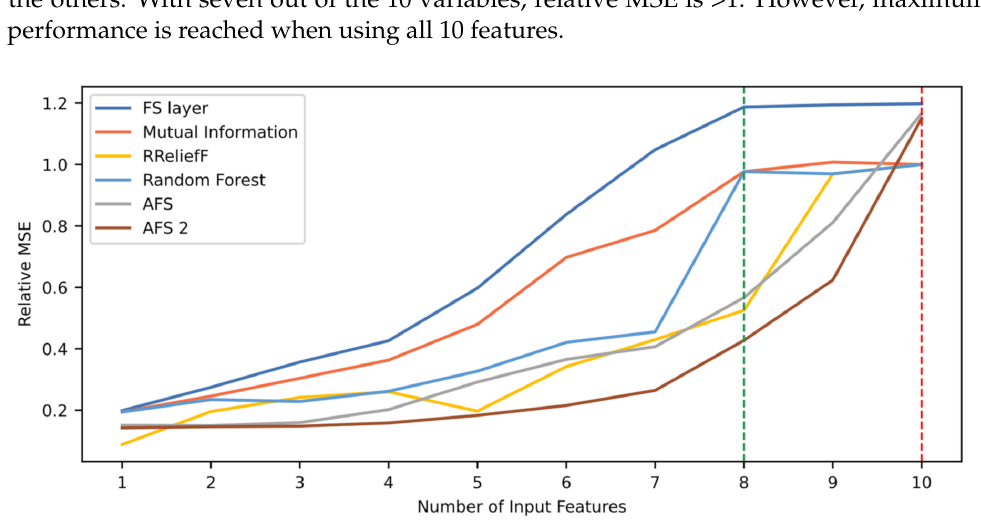
Figure 13. Comparison of relative MSE based on six different rankings for NGTP dataset. The red and green dotted lines indicate the number of features needed when using the FS layer technique to reach maximum performance and a 95% of this value,